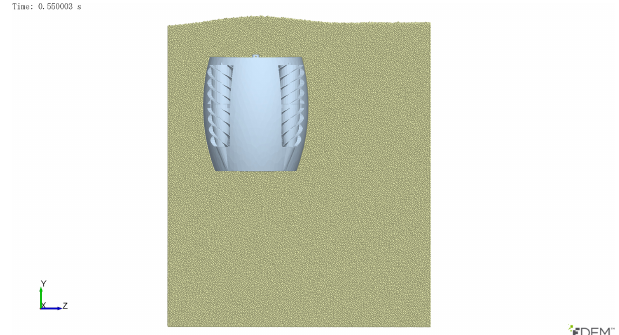
Figure 23. The detector turns to the simulated initial